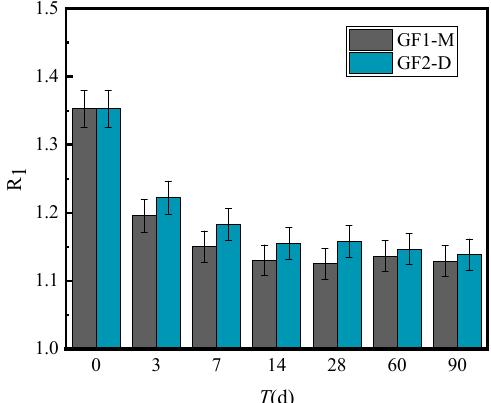
Figure 8. Unconfined compression strength ratio of VGM-30 and general gradations.